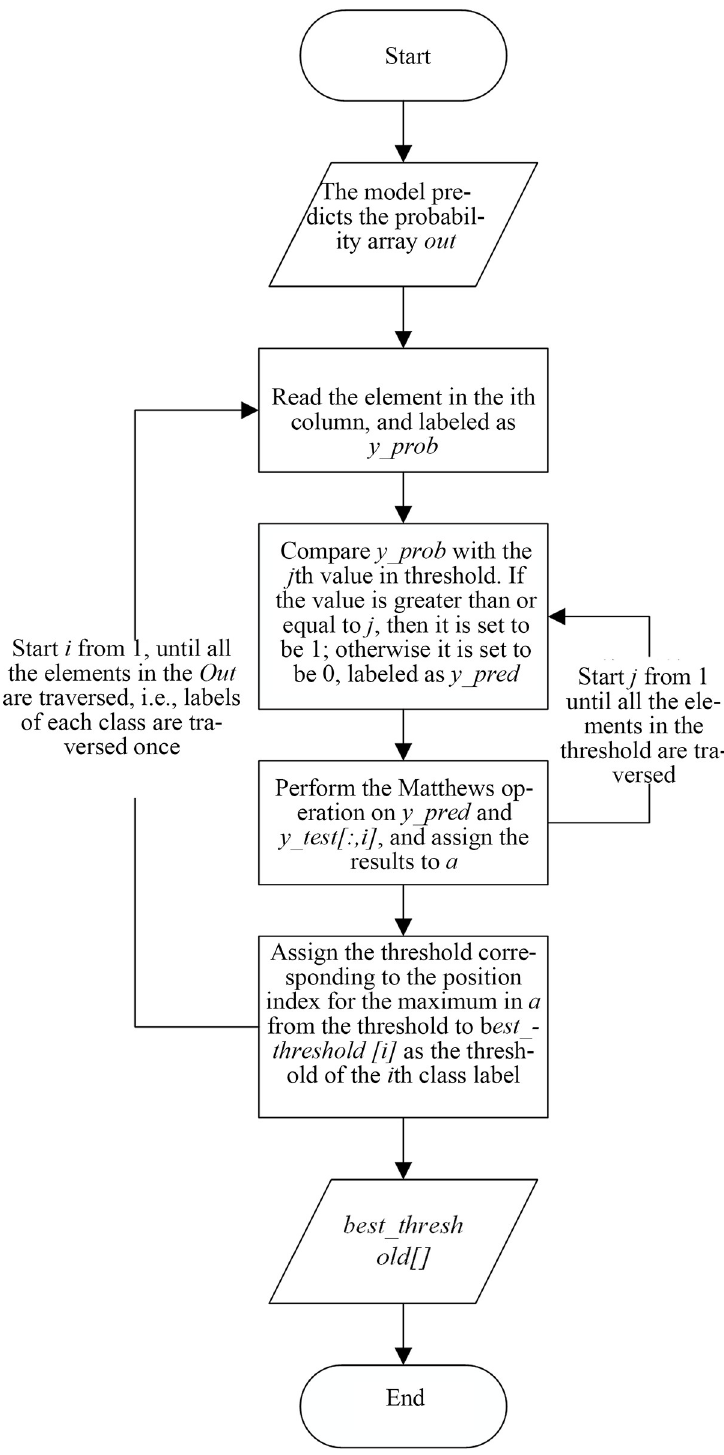
Fig 2. Flow chart of threshold